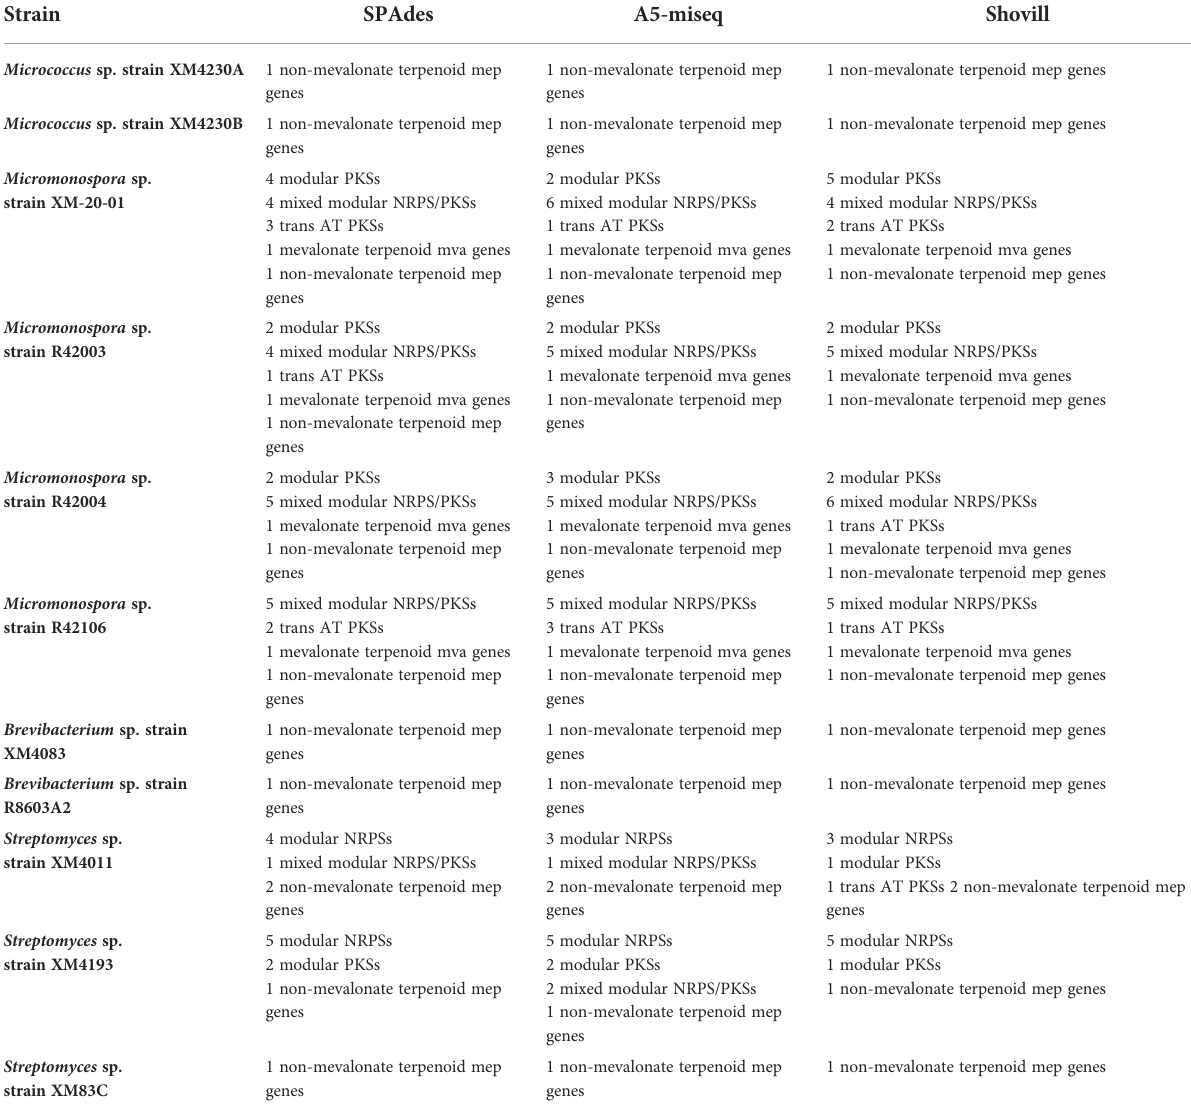
TABLE 7 NP.Searcher results for actinomycete genomes based on assembly method.